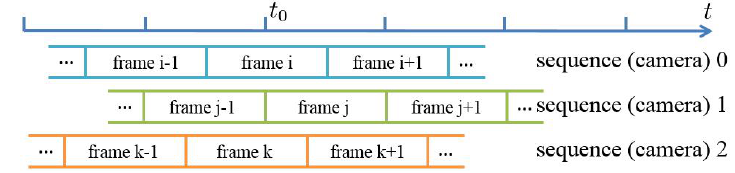
Figure 8. Frames without alignment. The cameras fail to simultaneously capture an event at time t 0 because frames from different sequences start to record at different times.